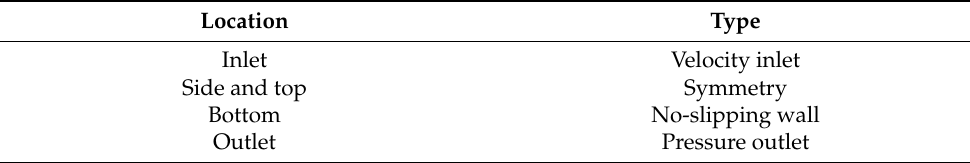
Figure 3. Computational domain with mesh configuration. Table 3. CFD Boundary Conditions.